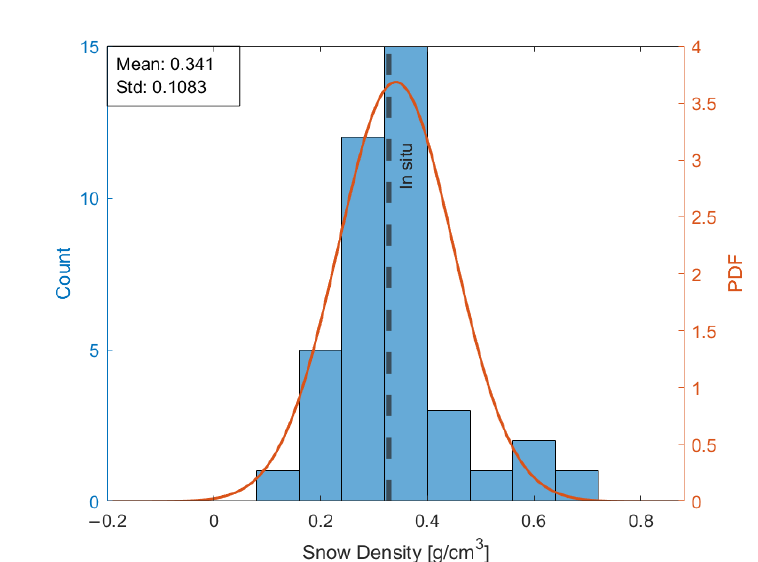
Figure 10. Distribution of density estimates from 40 measurements. Mean in situ snow-profile density shown as dashed